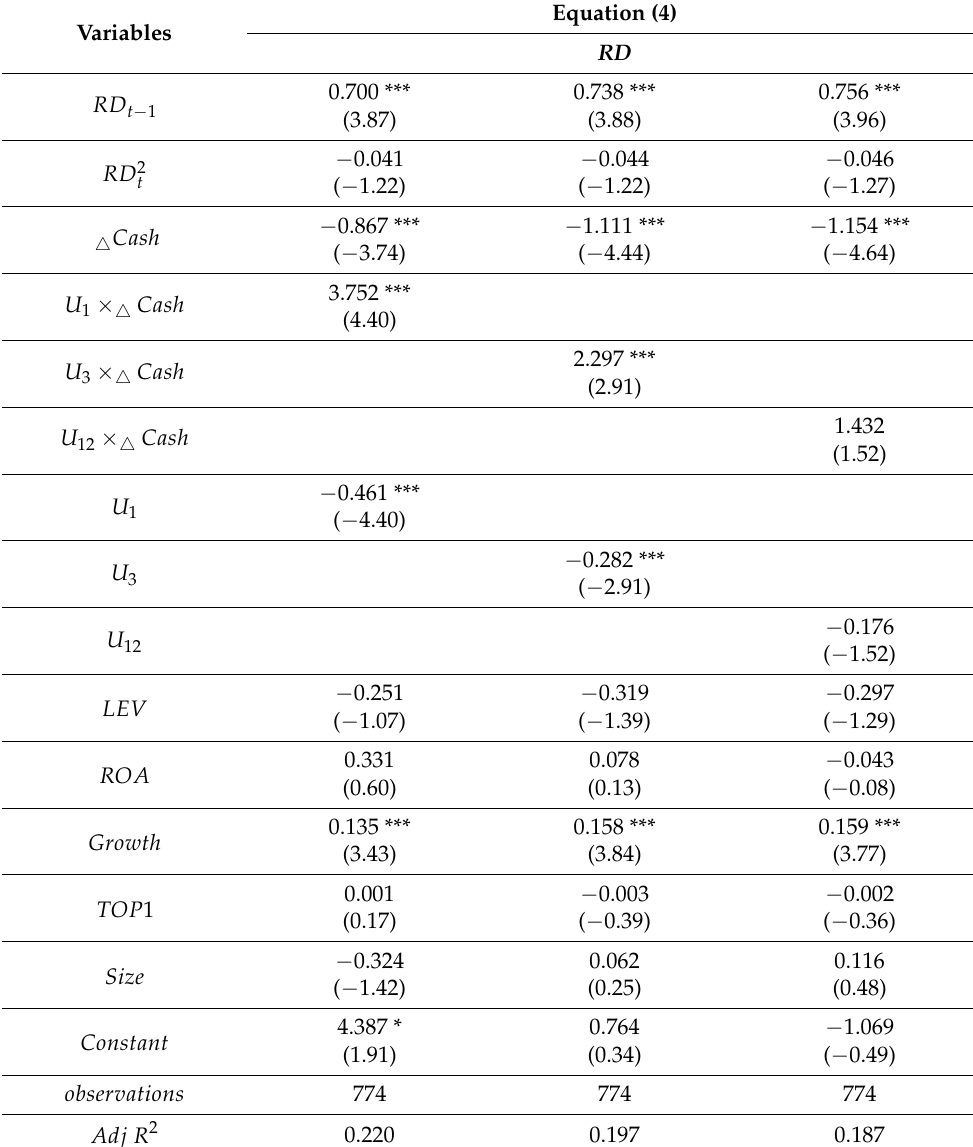
Table 4. The impact of monetary policy uncertainty on the R&D investment smoothing